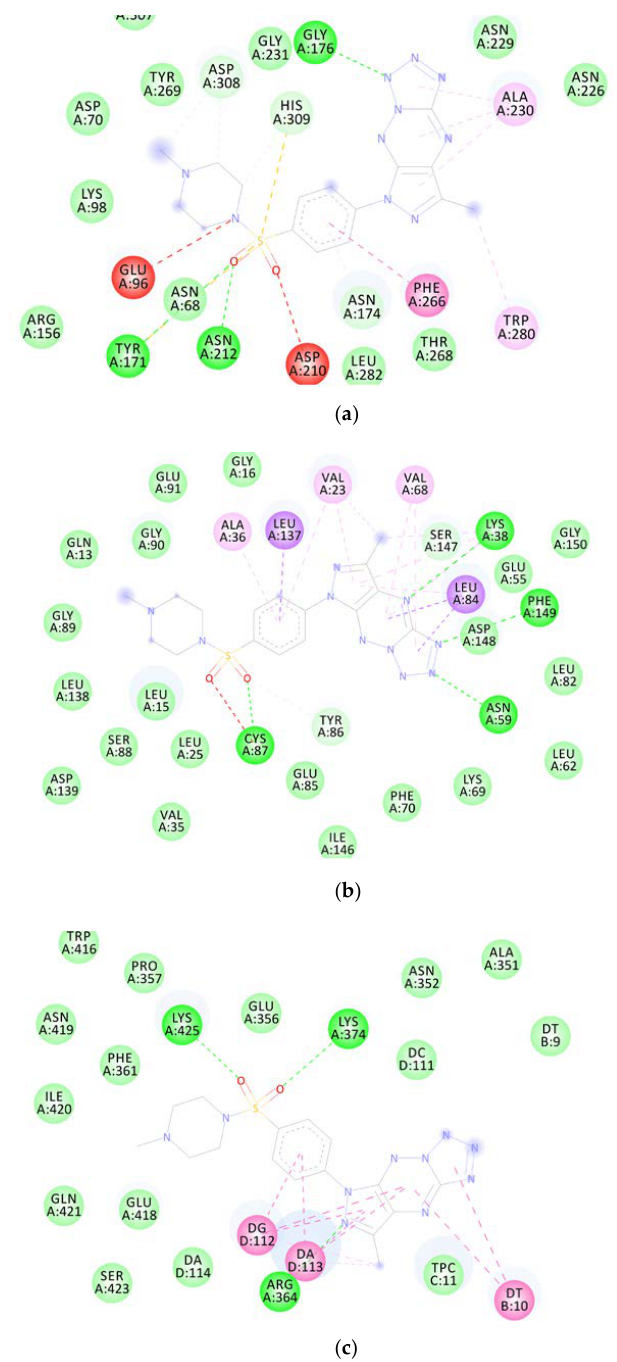
Figure 12. Graphical representation of molecular docking results: two-dimensional binding interac- tions of MM137 with human APE1 ( a ), CHK1 ( b ), and TOPO1 ( c